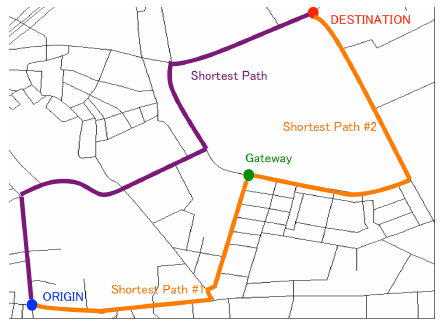
Figure 3. Example of GSP algorithm